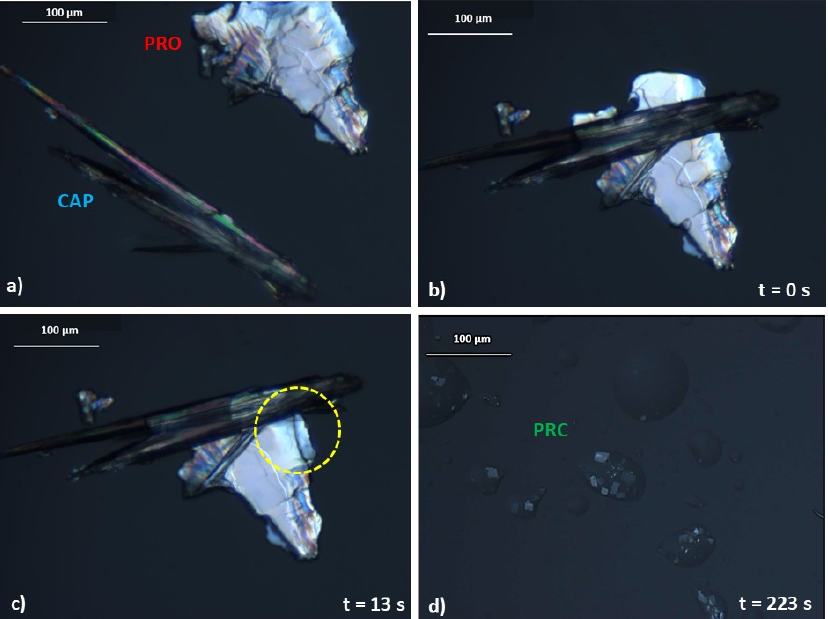
Figure 6. Images of polarised light microscopy experiment. The experiment was conducted at ambient temperature. ( a ) Crystal morphology of pure PRO and CAP. ( b ) PRO and CAP are brought into physical contact. ( c ) A liquid intermediate is formed after 13 s of bringing PRO and CAP into contact. The formation of a liquid intermediate is highlighted by a yellow circle. ( d ) After nearly 4 min, a new phase is formed.